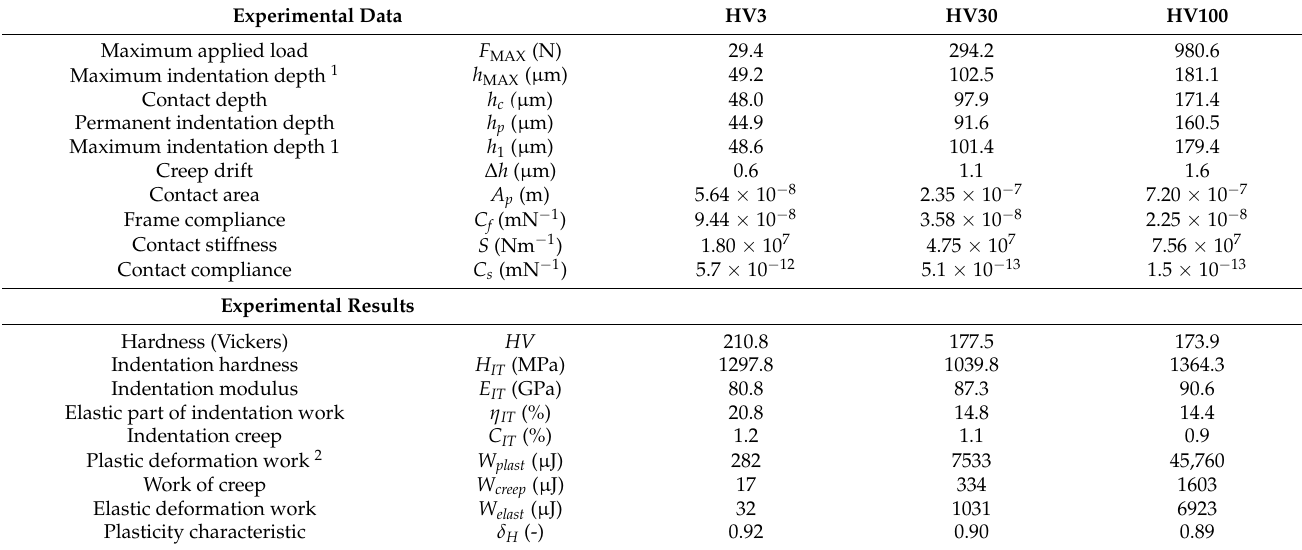
Table 2. Data of the HV test results on stainless steel.